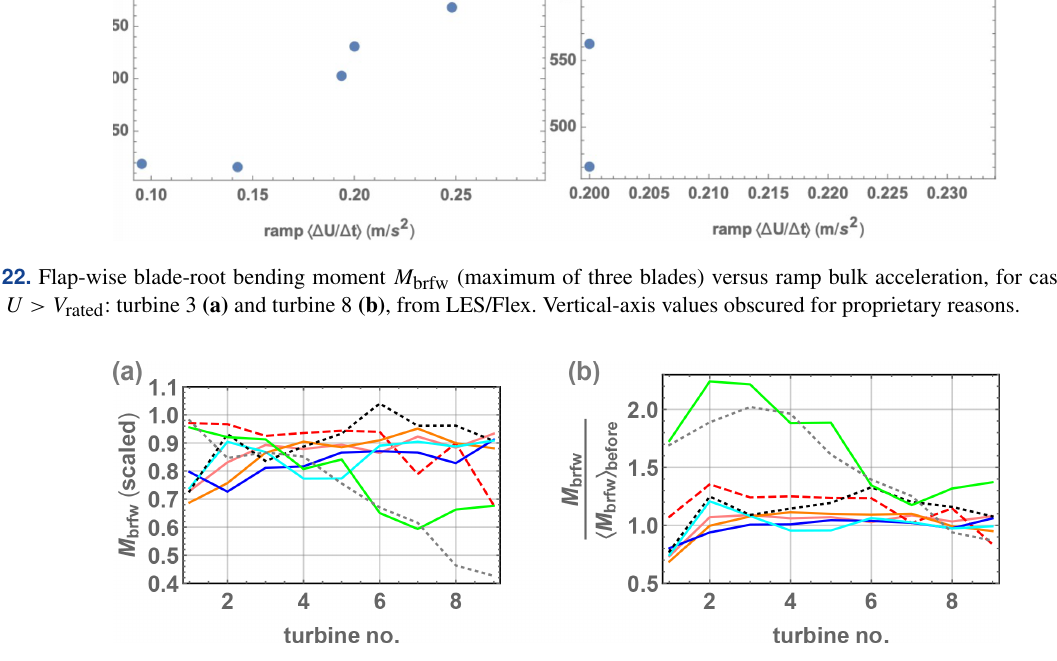
Figure 23. Mean flap-wise blade-root bending moment M brfw during ramp passage for all cases (averaged over all blades) versus distance into the farm (recalling turbine separation of 7 D = 560m). (a) In arbitrary units (proprietary); (b) normalized by pre-ramp values. Color/case legend same as Figs. 11–12, 14–19, and 23.